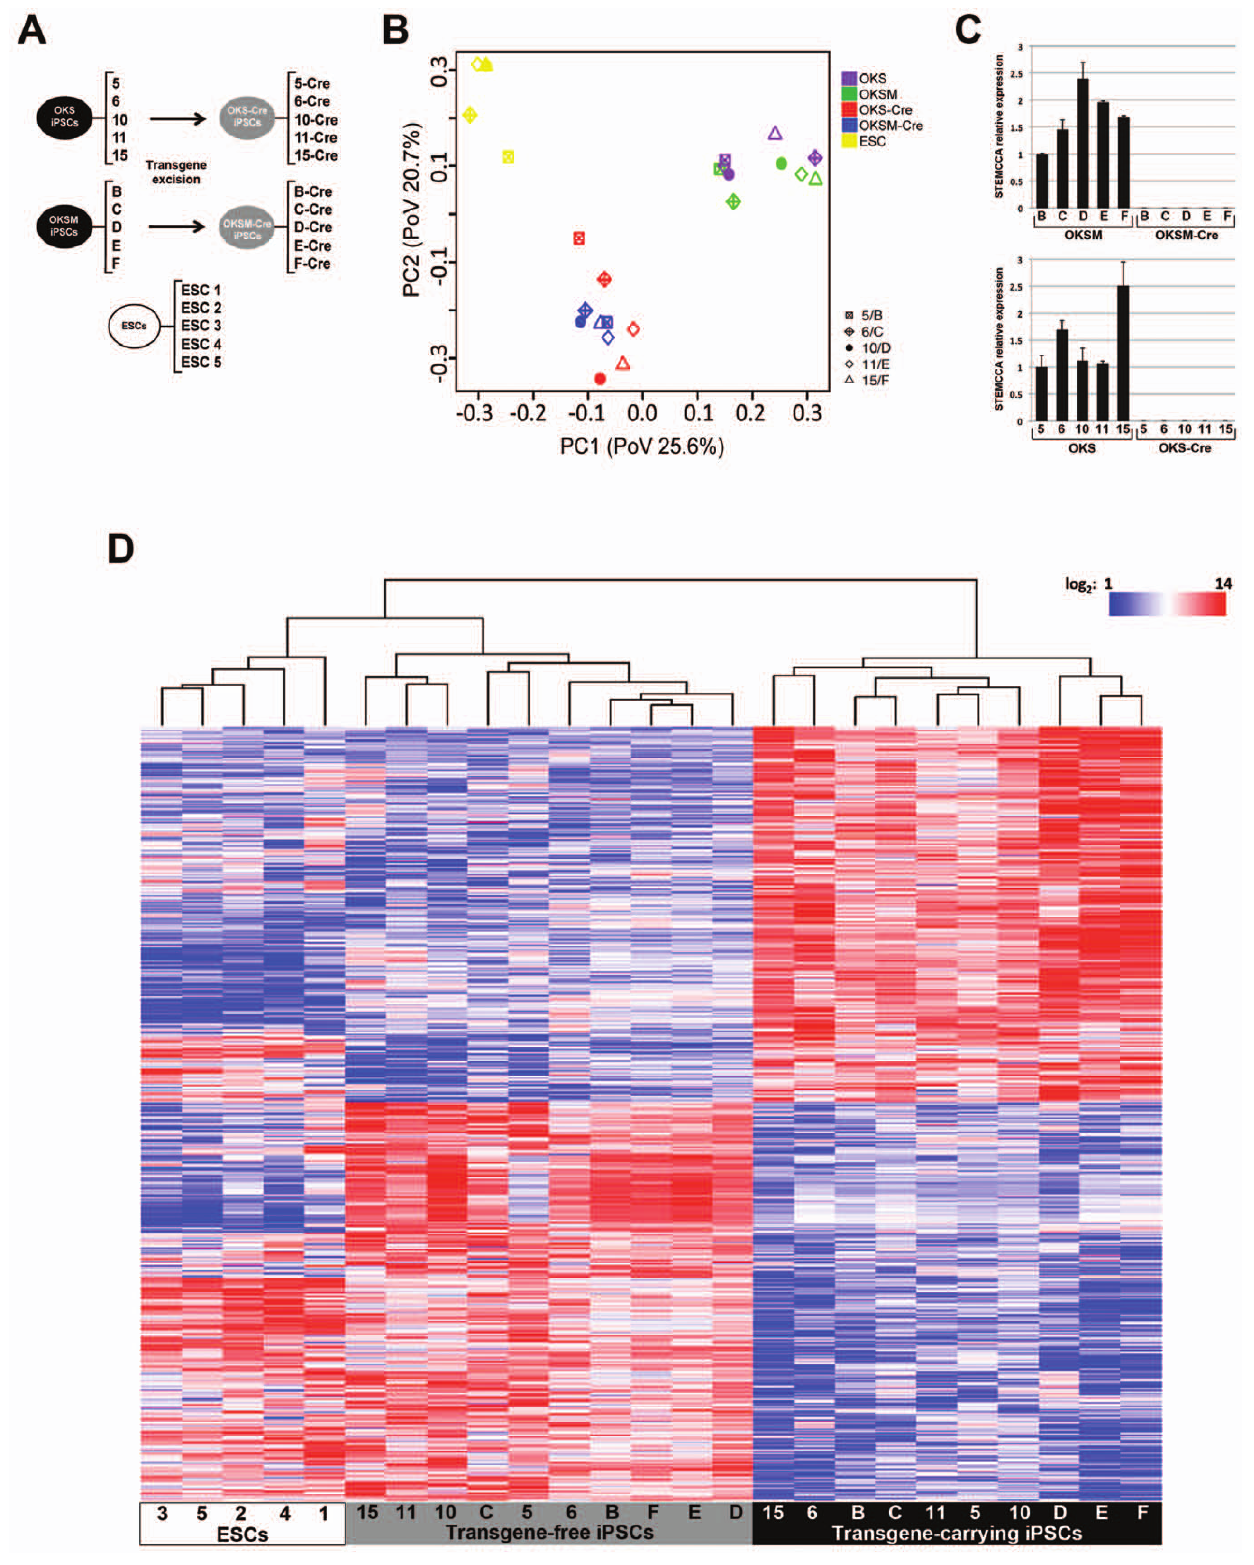
Figure 1. Global gene expression differences between iPSCs and ESCs are attenuated following excision of a lentiviral reprogramming cassette. (A) Schematic representation of the different groups of iPSC/ESC lines subjected to microarray analysis. iPSCs carrying a single copy of a ‘‘floxed’’ STEMCCA vector encoding either three (OKS) or four (OKSM) reprogramming factors were treated with Cre-recombinase to generate transgene-free OKS-Cre and OKSM-Cre iPSC clones. Five subclones of the Sox2 -GFP/M2rtTA ESC line were isolated, expanded and included